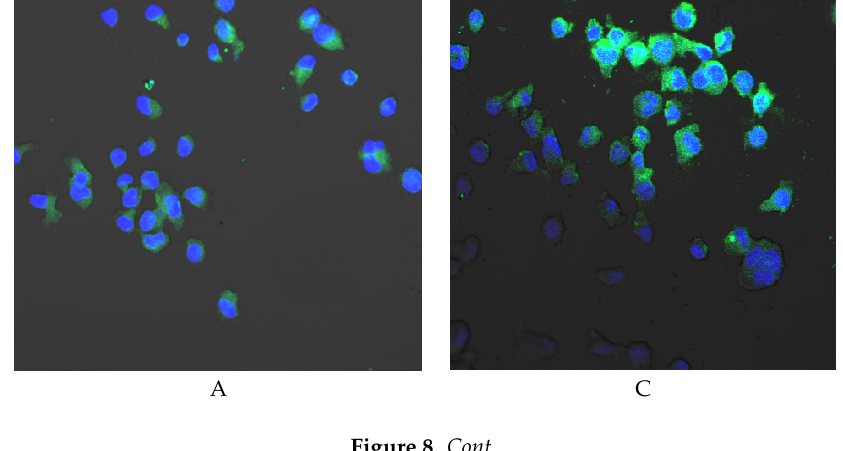
Figure 7. COX-1 protein expression in monocytes. Enzyme protein expression (70 kDa) was determined using the Western blot method. Representative Western blots of COX-1 protein ( A ) and densitometric analysis of COX-1 protein normalized to β-actin ( B ) in monocytes were shown. Cells were cultured for 24 h (B24) and 48 h (B48) in RPMI medium with 10% FBS with Biodentine TM , after incubation the cells were harvested by scraping and protein concentration was measured. Control cells were incubated in RPMI medium with 10% Fatal Bovine Serum (FBS) for 24 h as control 24 (C24) or for 48 h as control 48 (C48). Experiments were conducted as three separate assays. There were no statistically significant differences between the studied groups, p ≤ 0.5 (U-Mann Whitney test).